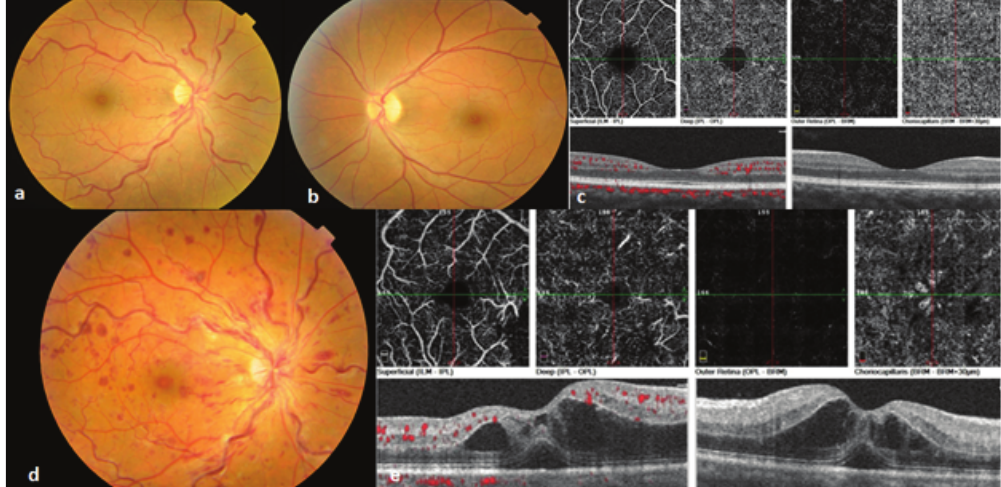
Figure 1. Fundus photos of the right (a) and left (b) eyes at presentation. Right eye funduscopy shows an increased vascular tortuosity and retinal dot and blot and flame shape hemorrhages that is compatible with an impending central retinal vein occlusion (CRVO). The normal optical coherence tomography angiography (OCTA) at presentation (c). After three weeks of follow up, her fundus photo was compatible with CRVO diagnosis with significantly increased vascular tortuosity and retinal hemorrhages (d). Her OCTA showed obvious macular edema and sub-retinal fluid in fovea